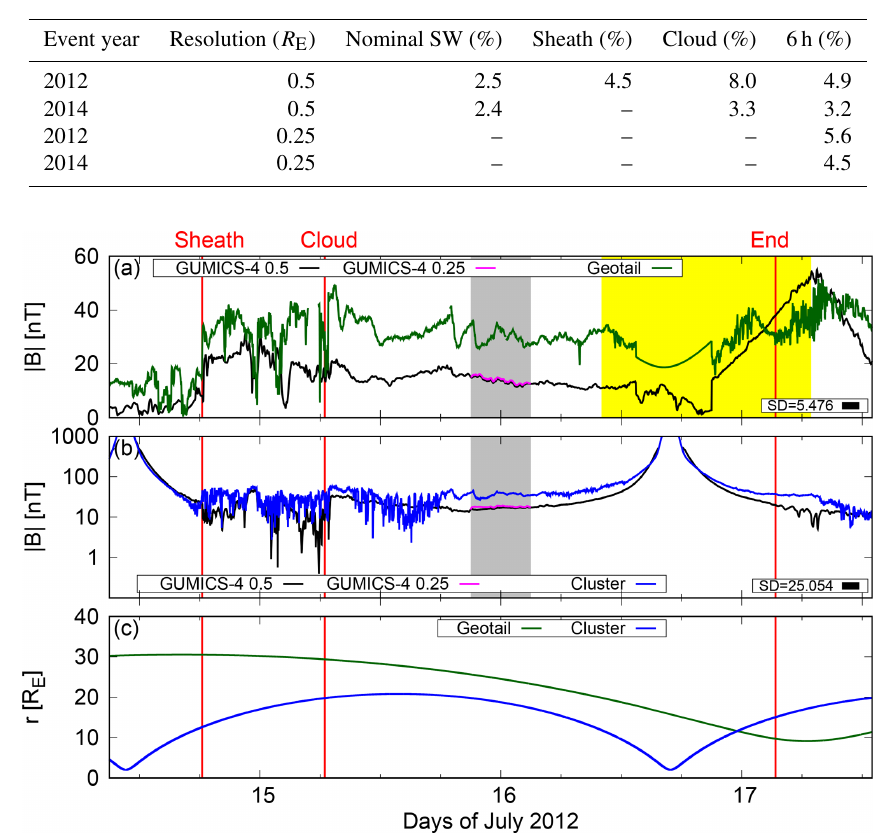
Figure 4. The time series of the magnetic field magnitude | B | along the orbits of Geotail (a) and Cluster 1 (b) during 14 July 09:00UT– 17 July 15:00UT, 2012 as measured by Geotail (green) and Cluster 1 (blue) and predicted by GUMICS-4 (black and magenta). Black and magenta curves in panels (a) – (b) show GUMICS-4 results with maximum spatial resolutions of 0.5 (black) and 0.25 (magenta) R E . (c) Radial distance of both spacecraft from the center of the Earth. Yellow-shaded regions indicate approximate time intervals when a satellite may exit the magnetosphere. Grey-shaded regions show the part of the ICME event simulated also using 0.25 R E maximum spatial resolution. Standard deviations (SDs) for observation vs. GUMICS-4 (0.5 R E resolution) datasets are given in panels (a) and (b)